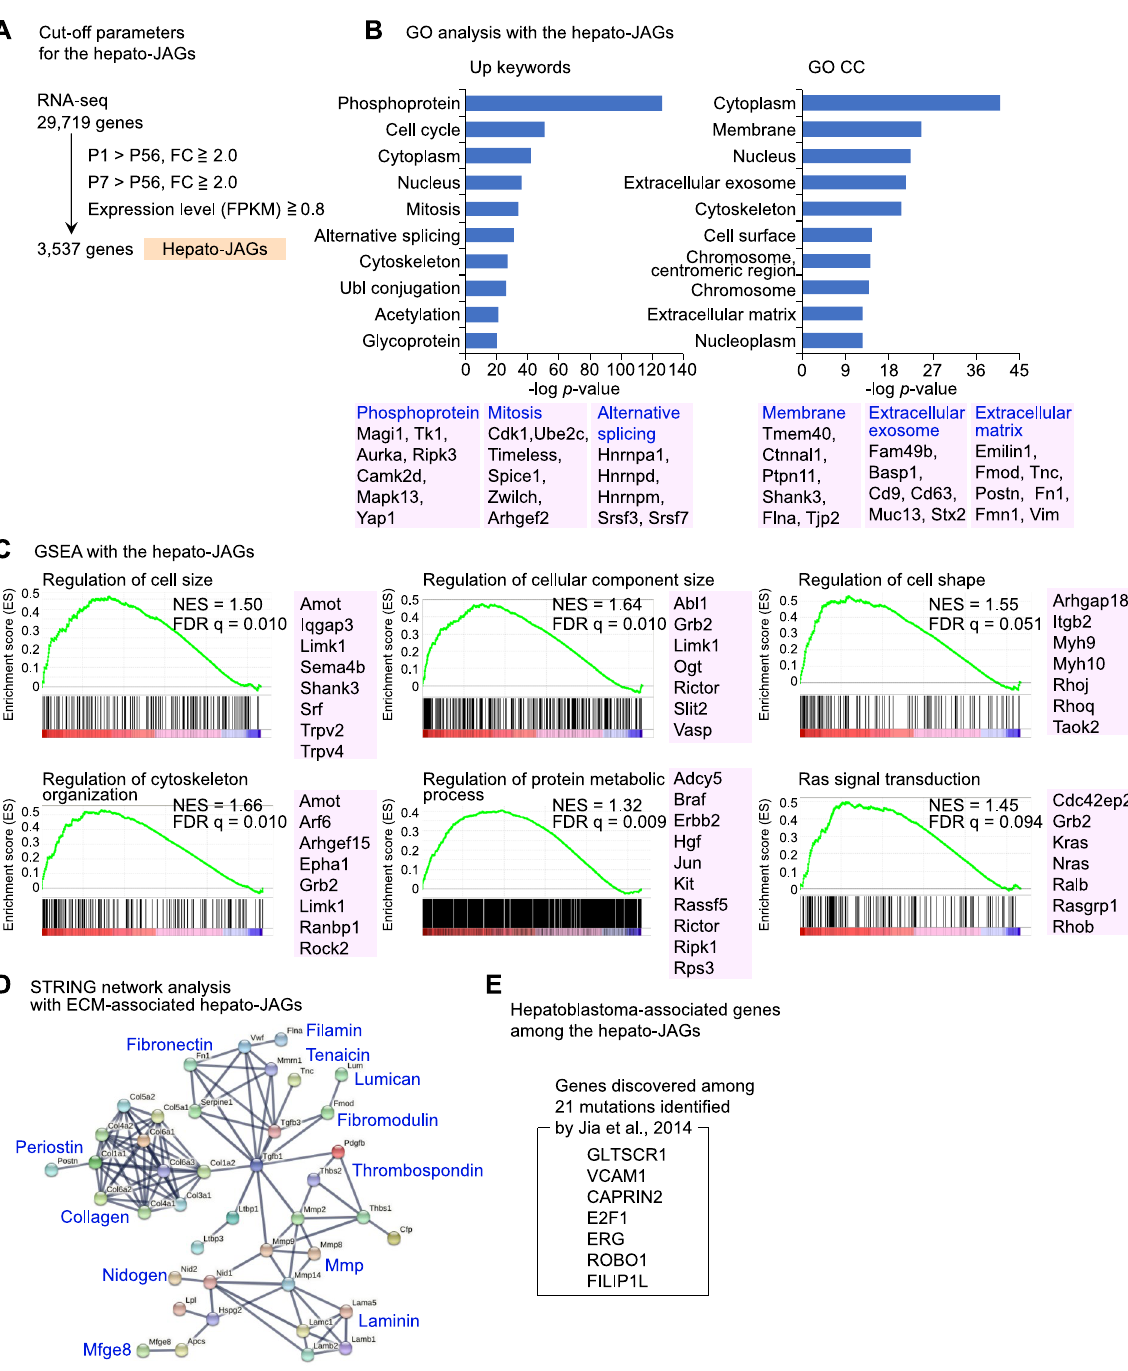
the dynamic transition in the cellular functions along the maturation of postnatal cardiomyocytes (Fig. 5C). Thus, the comprehensive gene expression profiling reveals the functional maturation dynamics and the pivotal genes characterizing each maturation stages in the postnatal cardiomyocytes.